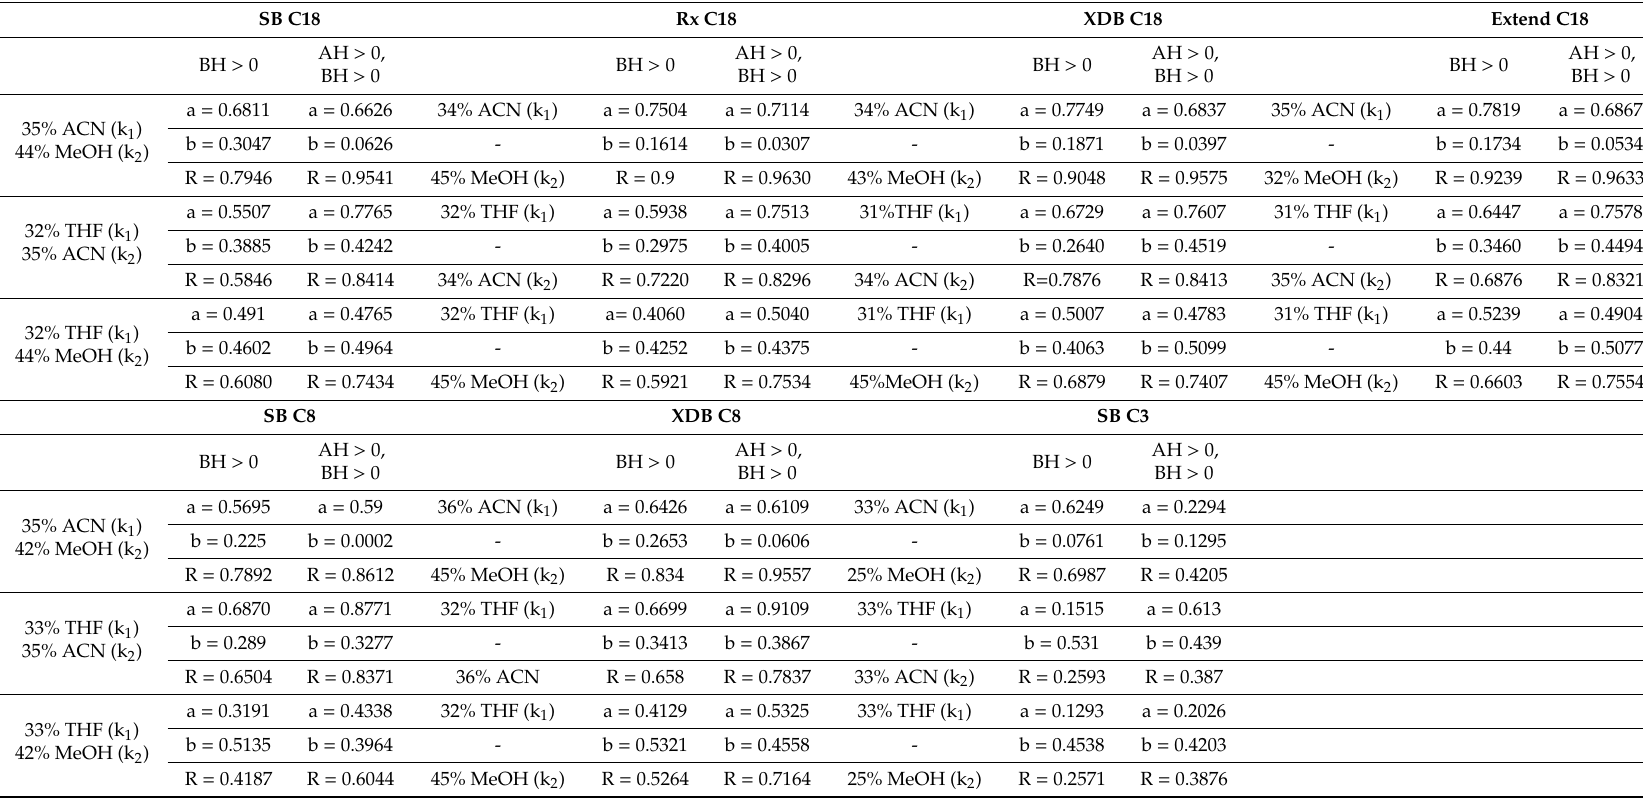
Table 1. The obtained parameters of linear equations and values of correlation coe ffi cient for investigated chromatographic